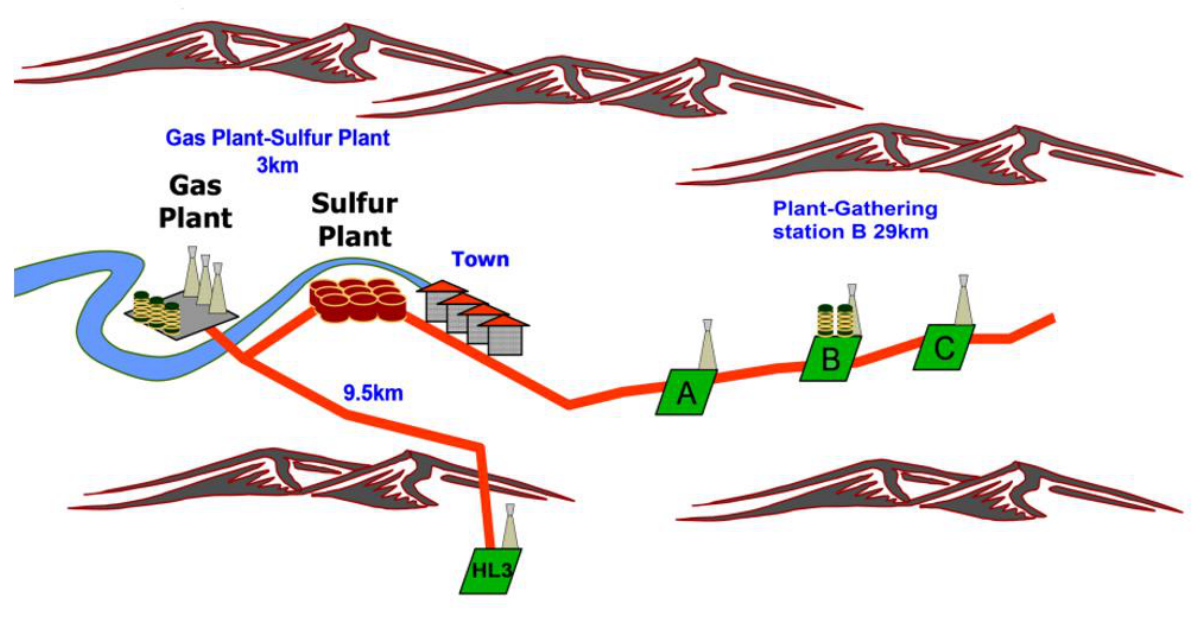
Figure 2—Sour gas development